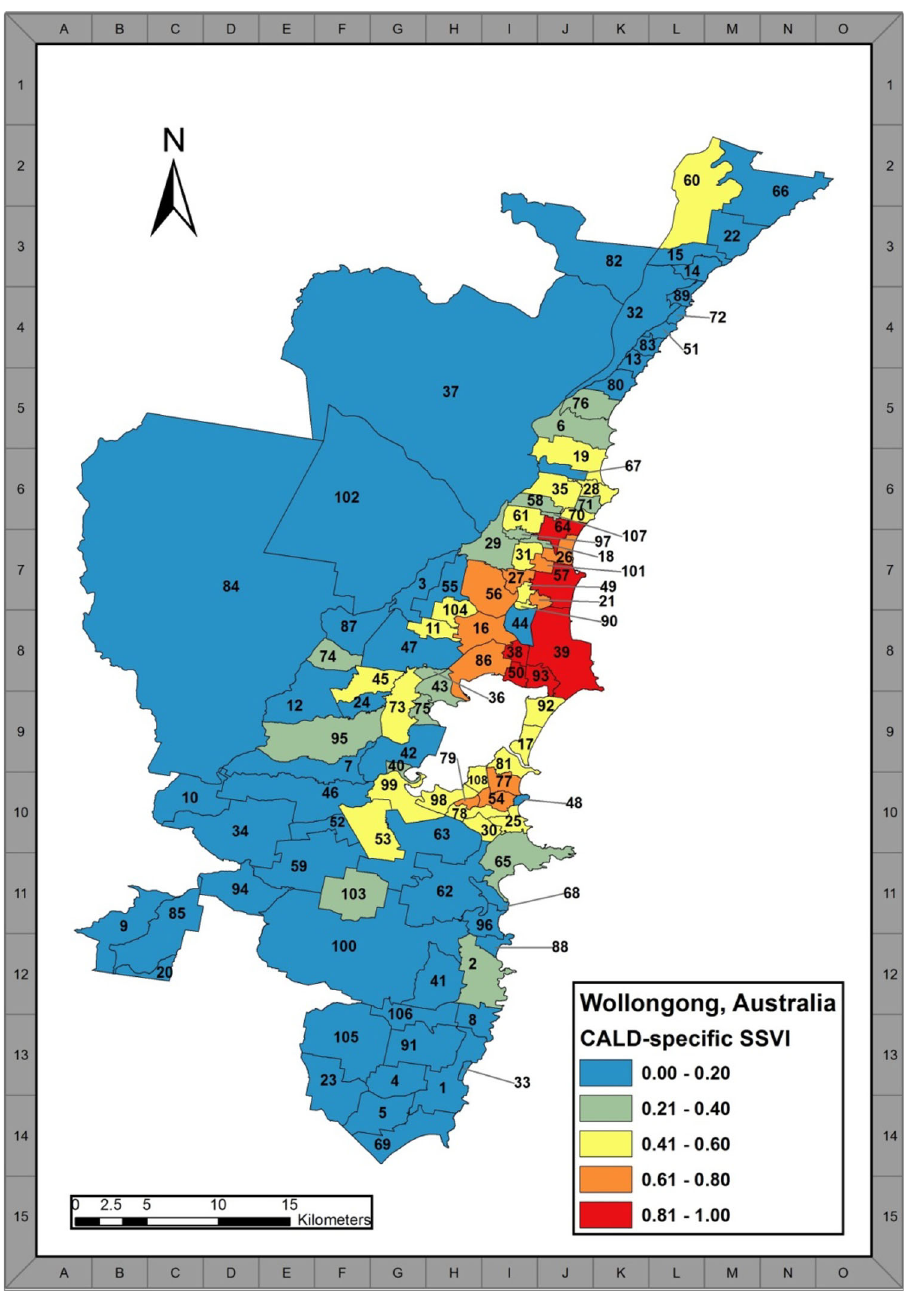
Fig. 3 Spatial distribution